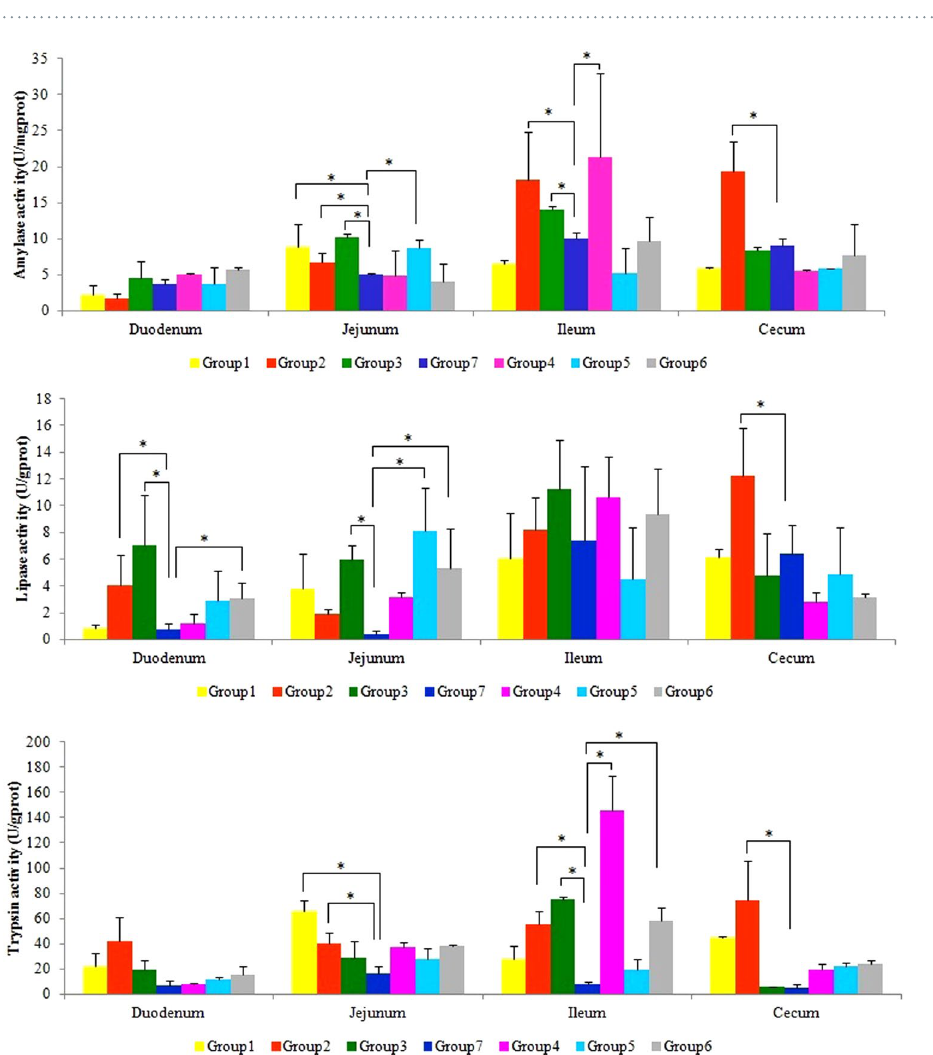
Figure 1. Levels of enzyme activity in chicken gut tracts. The intestinal positions are including duodenum, jejunum, ileum and cecum. ( A ) Amylase activity. ( B ) Lipase activity. ( C ) Trypsin activity. Asterisk ( * ) represents the significant difference of enzyme activity between certain trial groups (Group 1 to Group 6) and Group